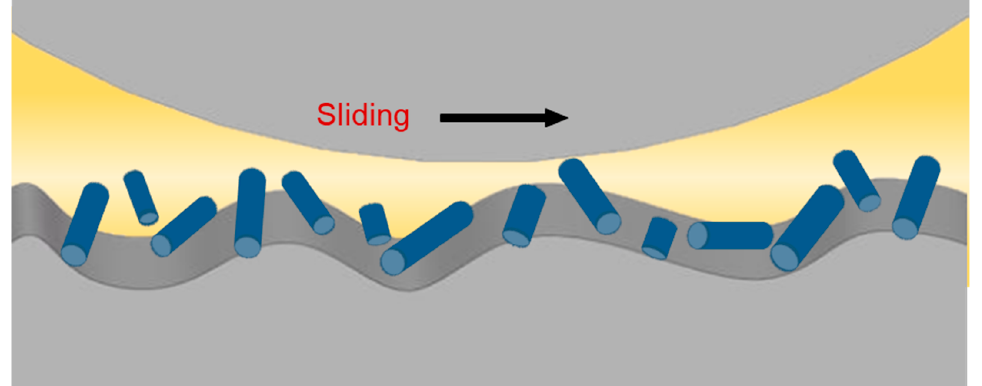
Figure 3. The “rolling bearing” effect of one-dimensional nanomaterials.